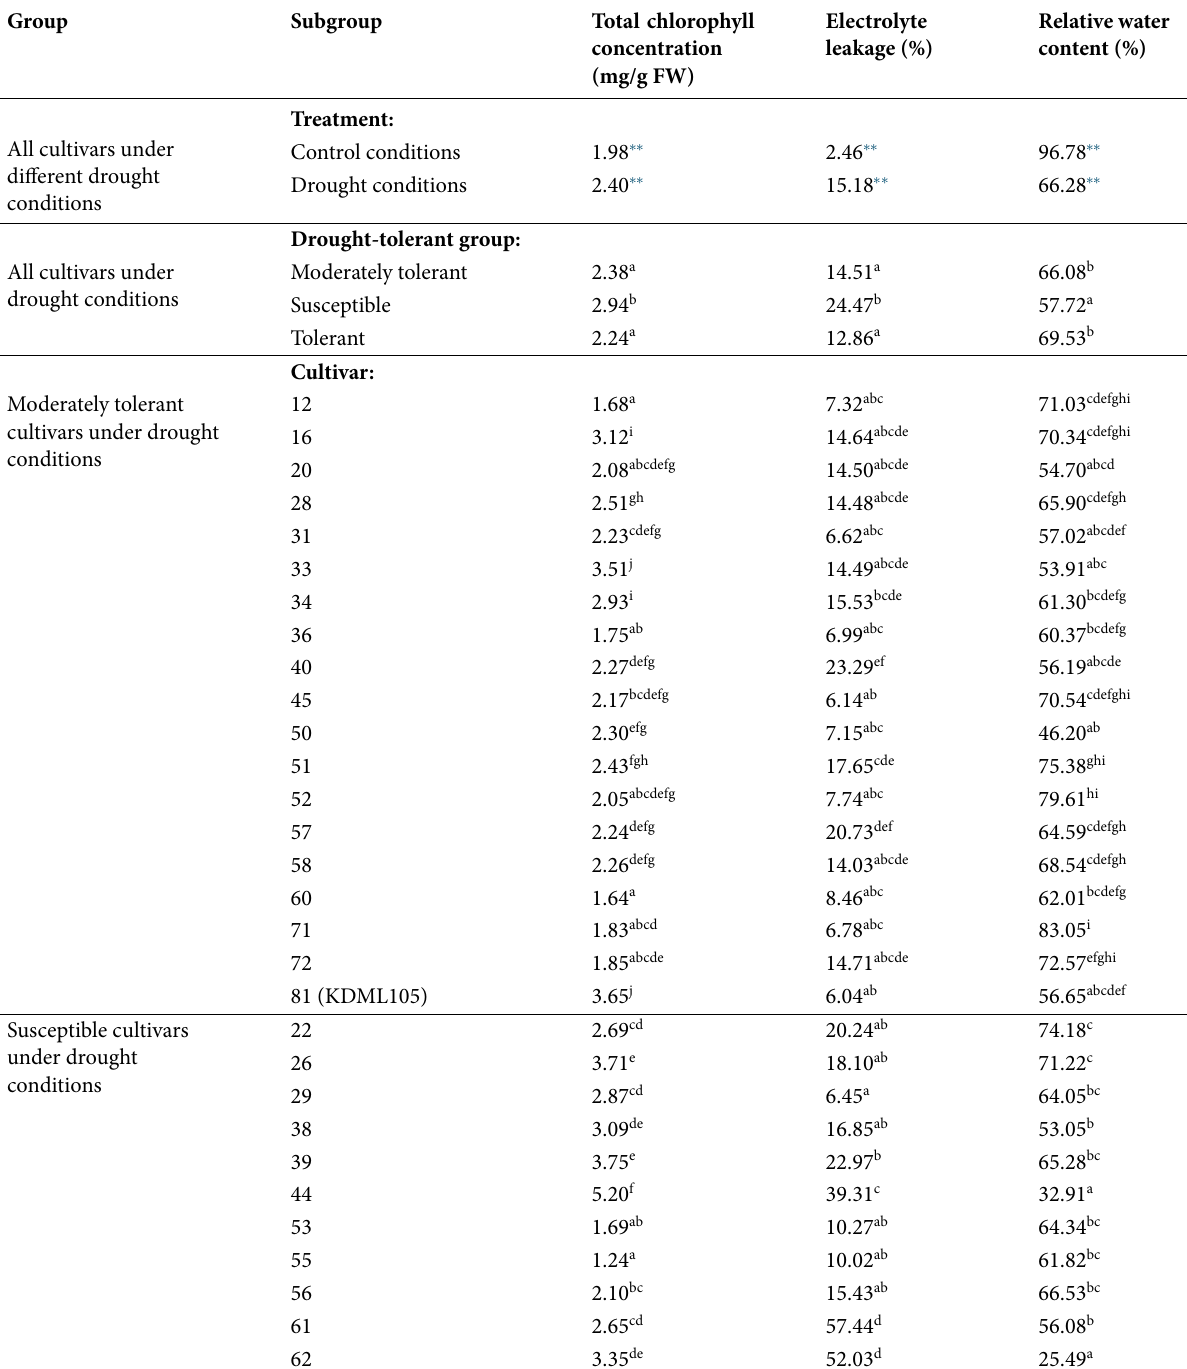
Table 3 Comparisons of the means of measured physiological traits, i.e., electrolyte leakage, relative water content, and total chlorophyll content, of plants under control conditions and drought stress